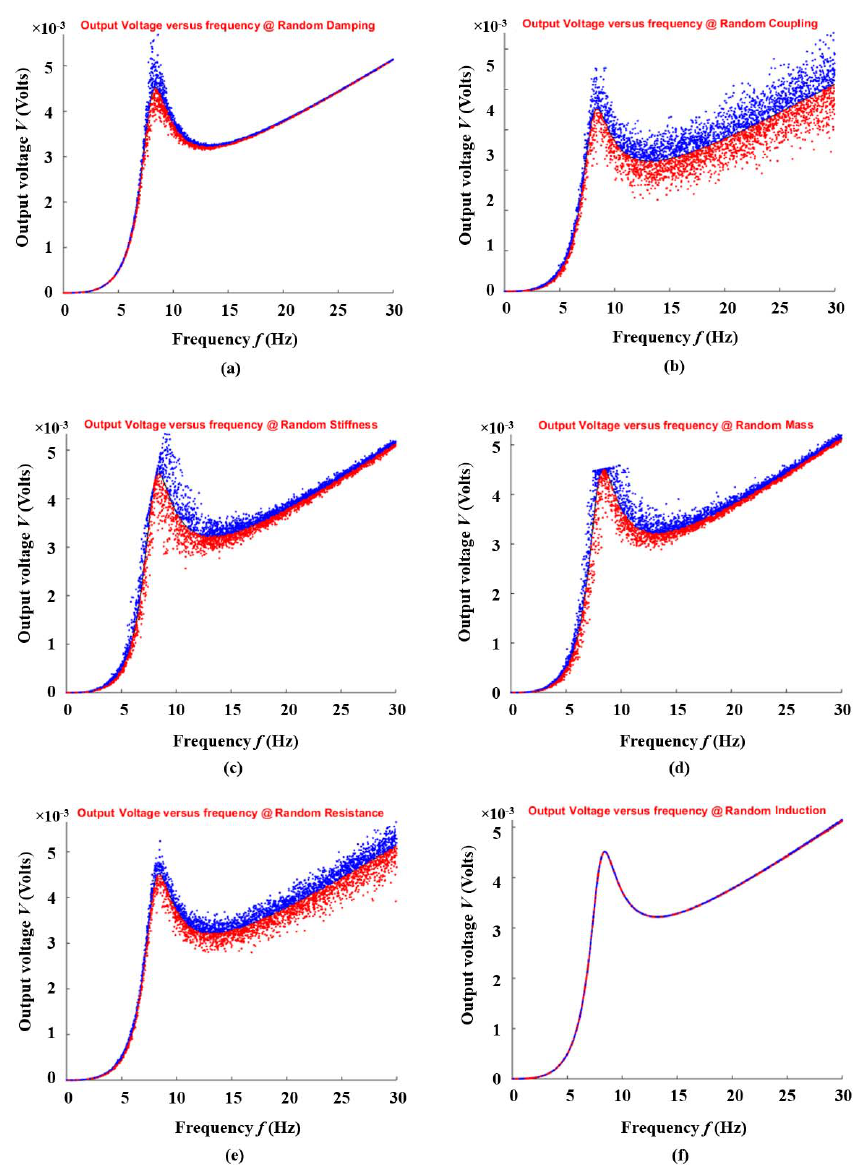
Figure 7. Simulated output voltage of the device versus frequency by changing the ( a ) damping; ( b ) coupling coefficient; ( c ) stiffness of spring; ( d ) mass; ( e ) resistance; ( f ) induction.